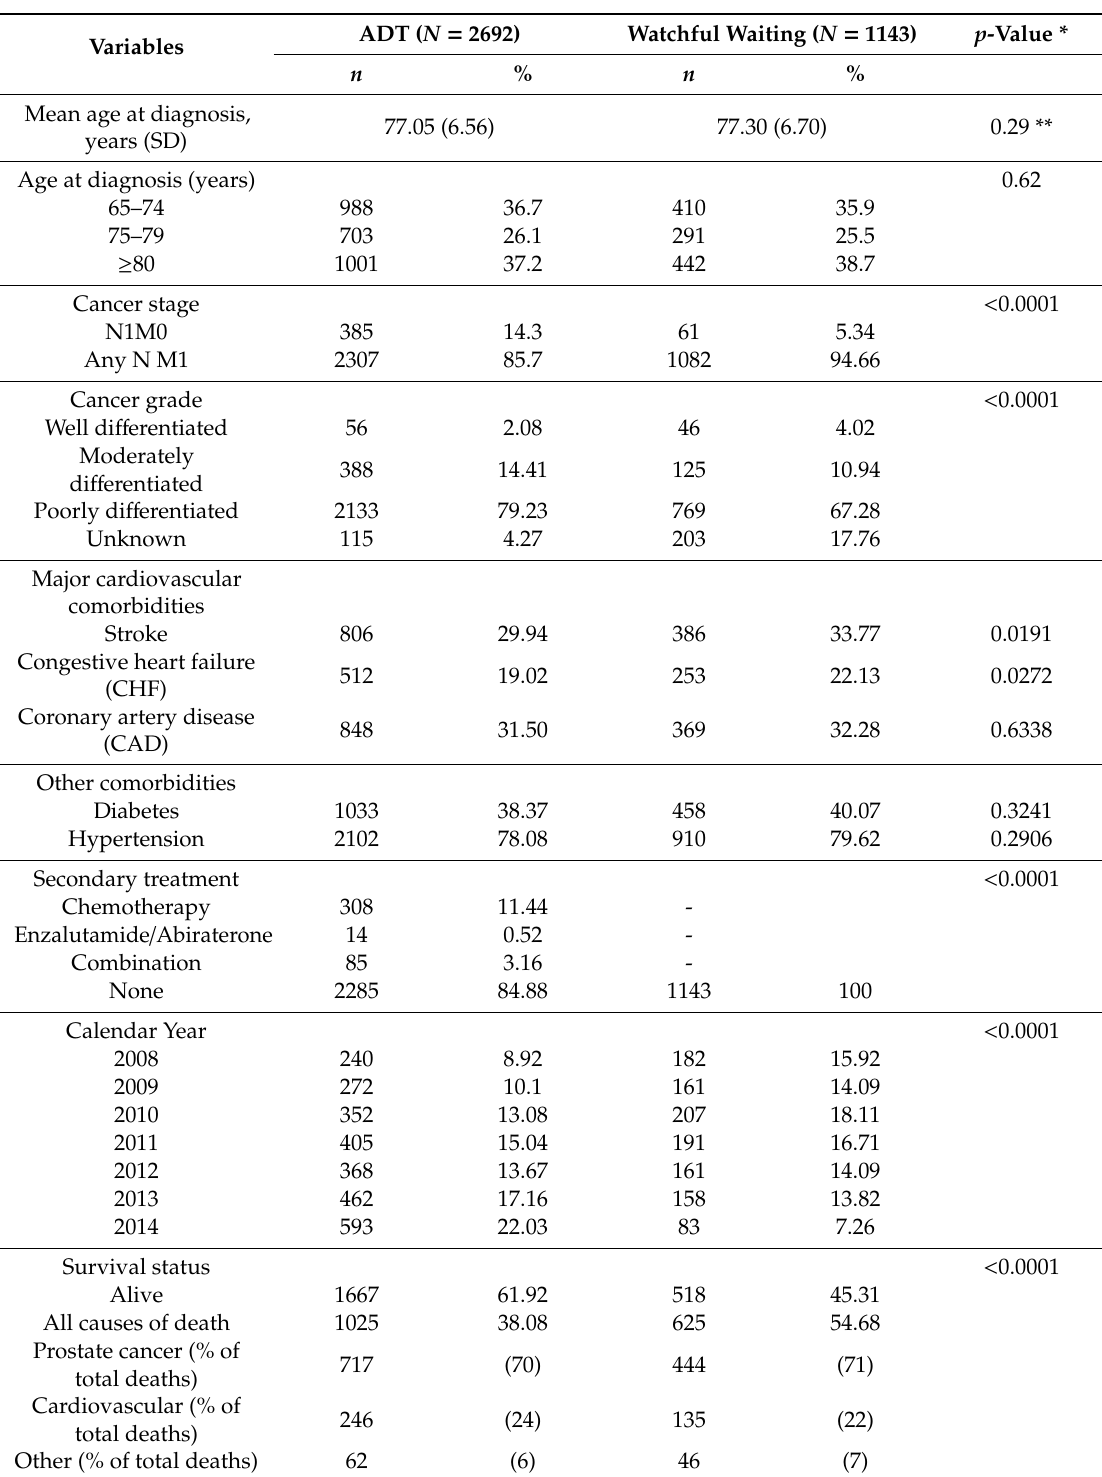
Table 1. Distribution of baseline patient characteristics according to the status of androgen deprivation therapy (ADT) within the first year after a cancer